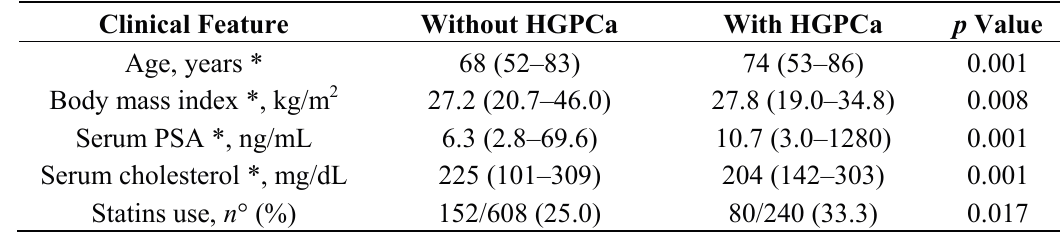
Table 2. Clinical characteristics according to the diagnosis of high-grade prostate